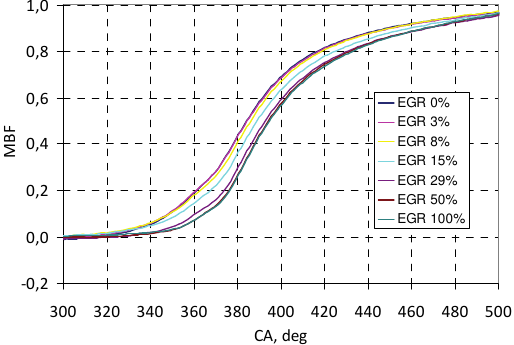
Fig. 10. Mass Fraction Burning course at different EGR valve opening level (1600 rpm, 190 Nm)